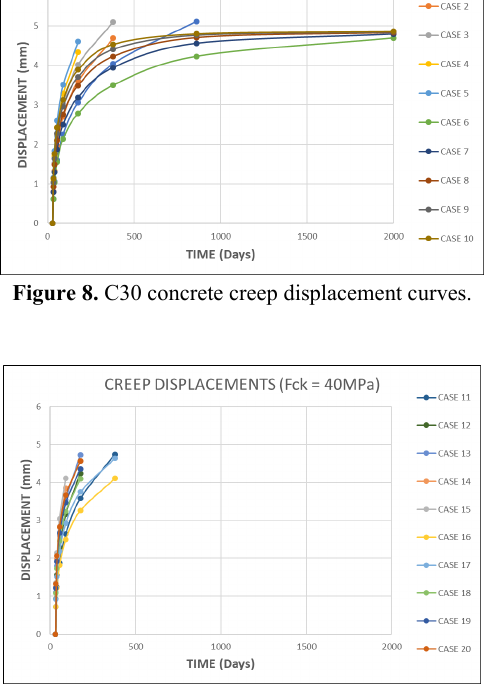
Figure 9. C40 concrete creep displacement